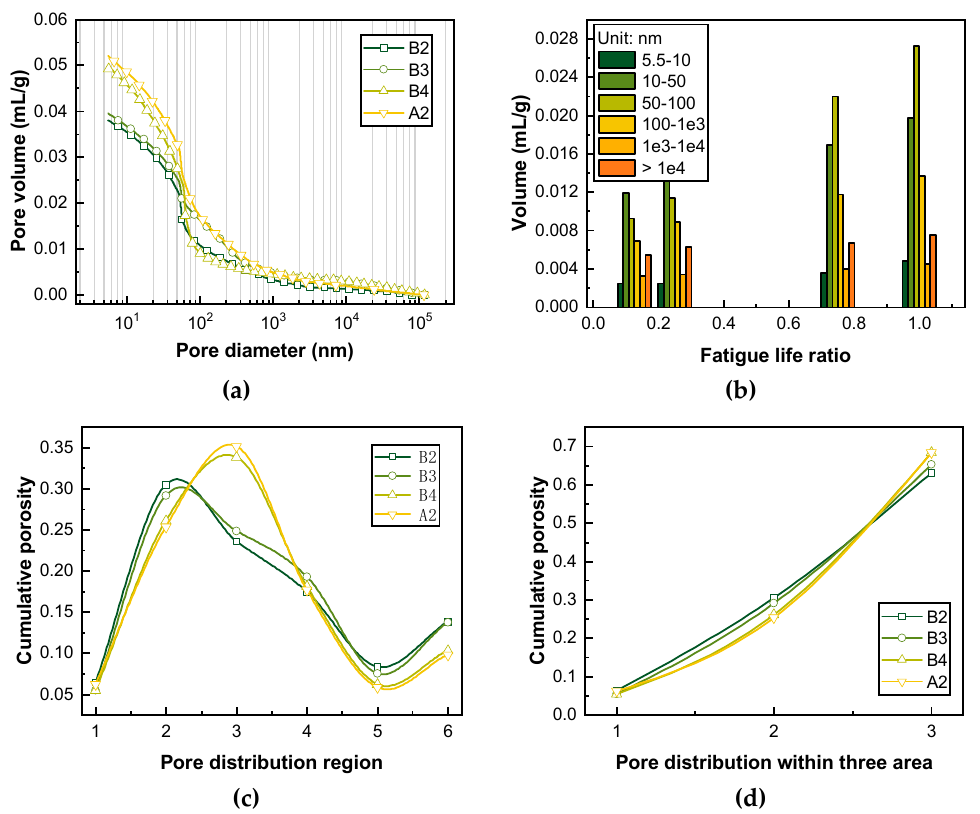
Figure 8. The cumulative porosity distribution of the fatigue-damaged concrete specimens: ( a ) cumulative pore volume; ( b ) cumulative pore volume of different regions; ( c ) regional cumulative porosity ratio distribution; ( d ) cumulative porosity ratio distribution.